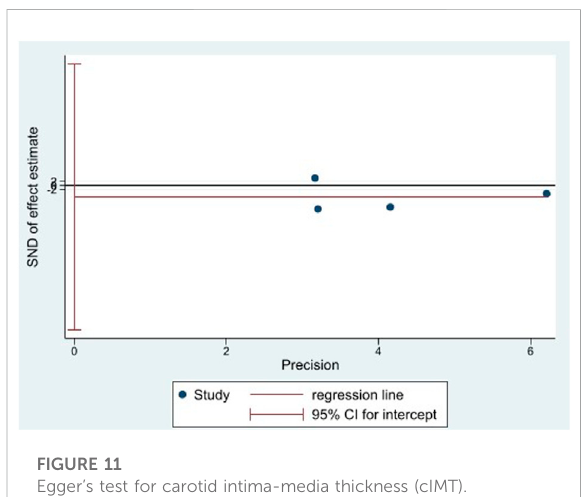
FIGURE 11 Egger ’ s test for carotid intima-media thickness (cIMT).